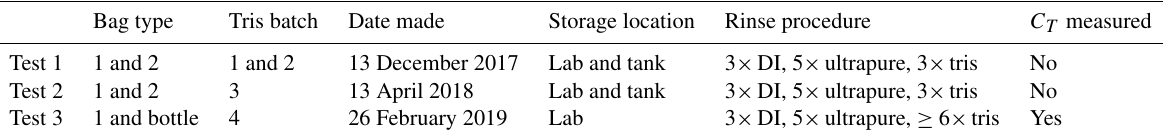
Table 1. Tris preparation and